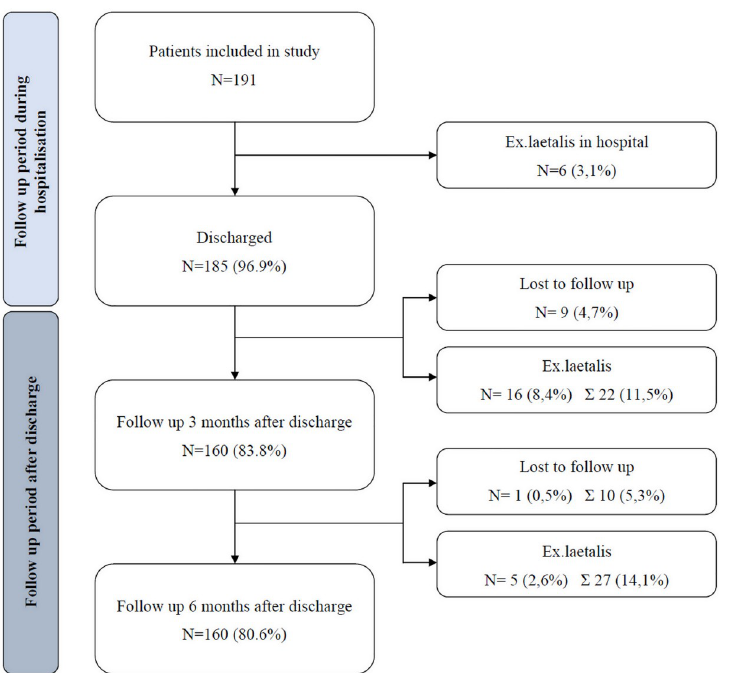
Fig 1. The flow of patients during the period of the